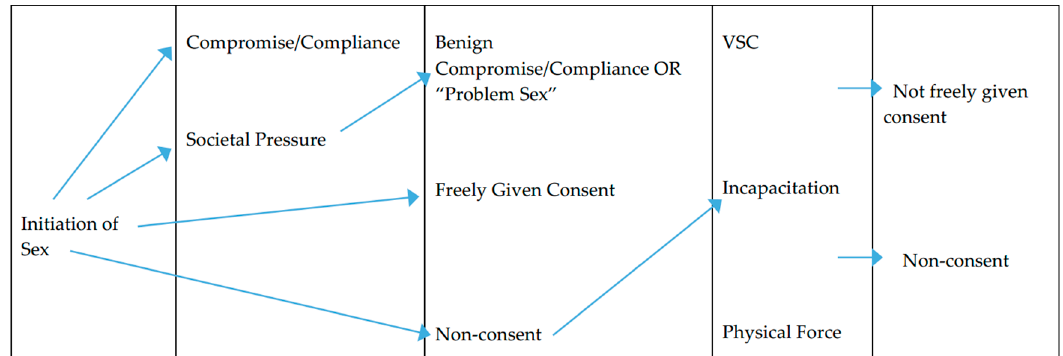
Figure 1. Relationship between coercion, compliance, and consent.